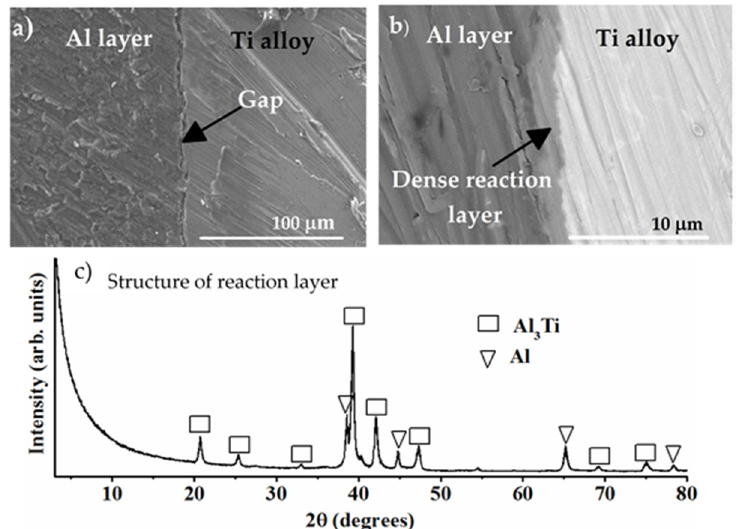
Figure 3. SEM image of Al layer formed on the Ti alloy ( a ), BSE image after heat treatment ( b ), and TF ‐ XRD of the reaction layer ( c ). Reproduced [101] from with permission from Elsevier